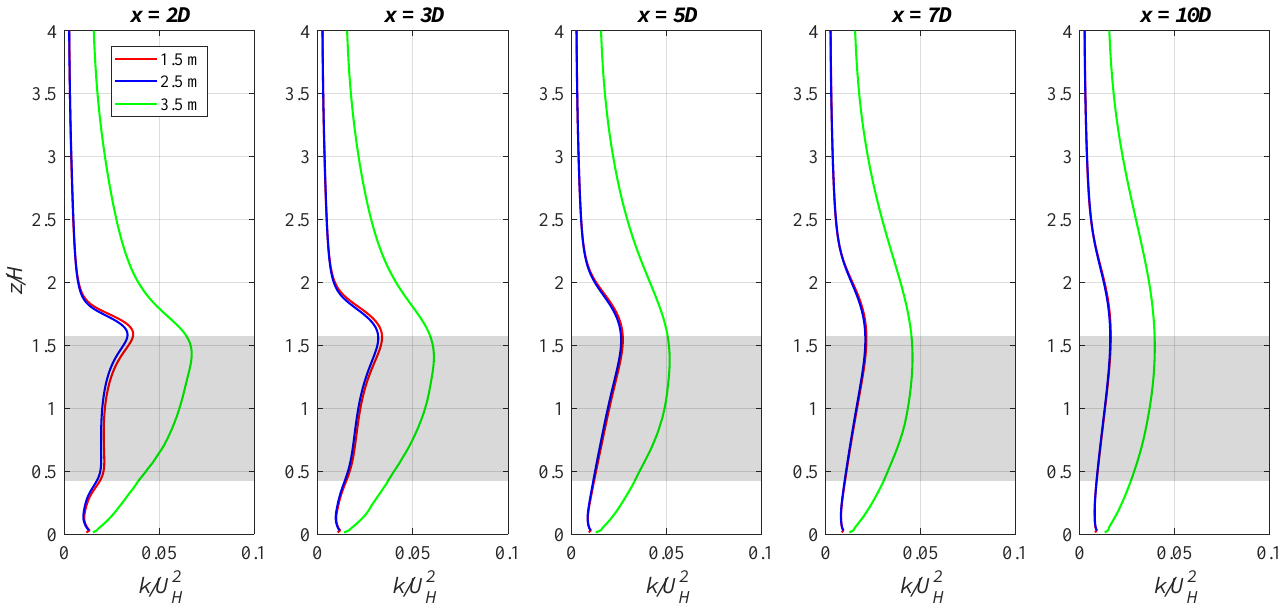
Figure 10. Vertical profiles of TKE from the midplane for different mesh resolutions (the shaded region depicts the rotor area) [4].